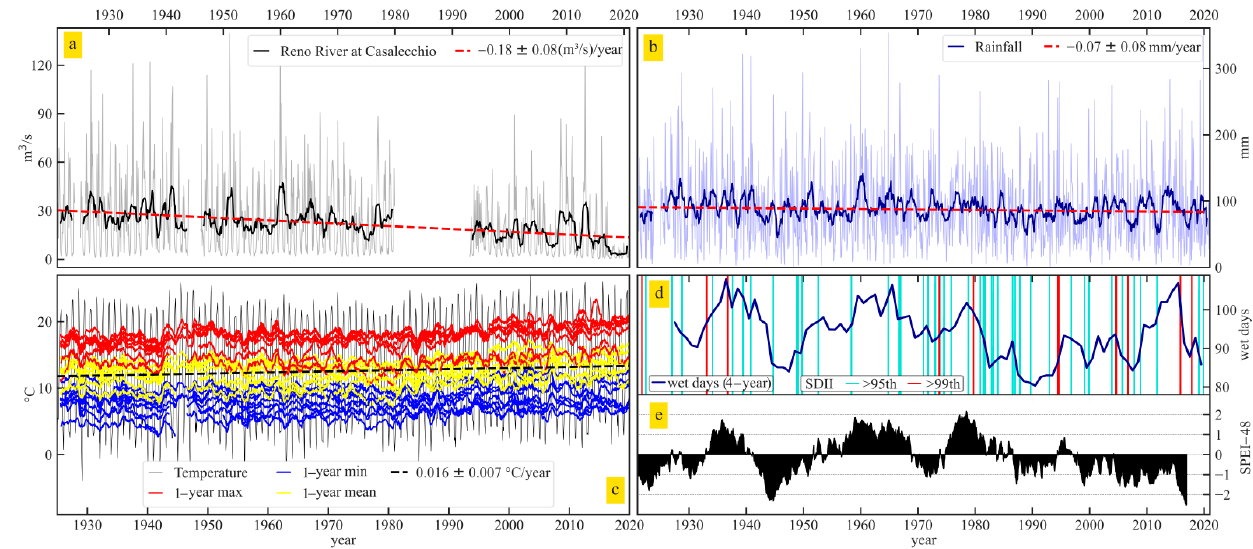
Figure 3. ( a ) Reno River discharge at the Casalecchio river gauge and ( b ) the stacked rainfall time series, both with 1-year low-pass filter time series (solid black and blue lines, respectively) and trend estimates (dashed red lines); ( c ) the stacked temperature time series (black), its trend estimate (dashed black line), and the 1-year moving average time series of max (red), mean (yellow) and min (blue) temperatures observed at the nine stations in this study; ( d ) the number of wet days filtered with a 4-year moving window (solid dark-blue line) and the SDII, showing only instances above the 95th (light blue) and 99th (red) percentiles; ( e ) the 48-month SPEI time series for the study site.